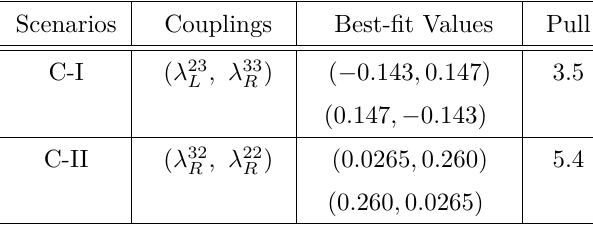
central values and their 1 σ uncertainties. In this analysis, we use a represenative value of the LQ mass as m = 1 . 2 TeV, which is congruous with the constraint obtained from LHC LQ experiment [165]. We further take into account the following two scenarios to obtain the best-fit values of the LQ